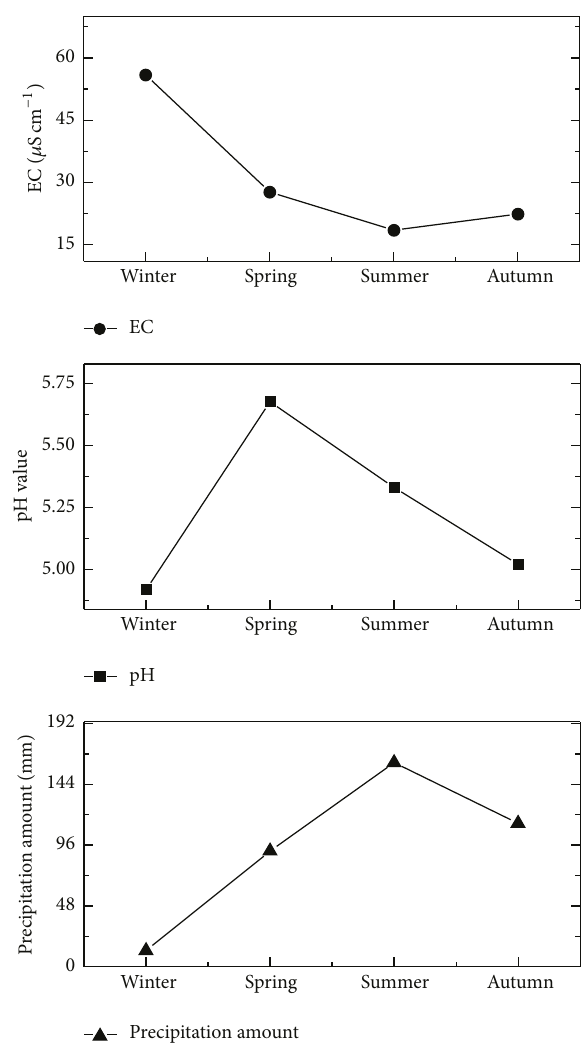
Figure 4: Seasonal variations of the two-year average EC, pH, and precipitation amount in